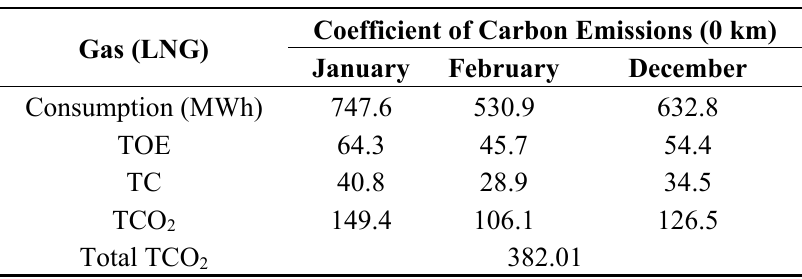
Table 9. CO 2 emission of gas